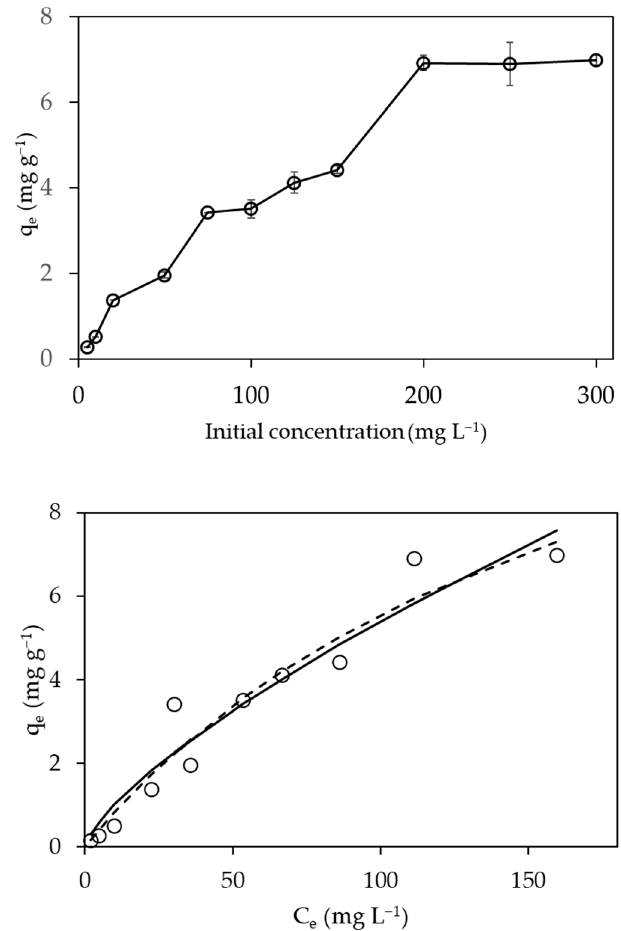
Figure 8. ( a ) Total adsorbed cisplatin vs. initial concentration of Si-DTC. ( b ) Adsorption isotherm plot calculated with Langmuir (solid line) and Freundlich (dashed line) models. Table 2. Parameters of the Langmuir and Freundlich models.